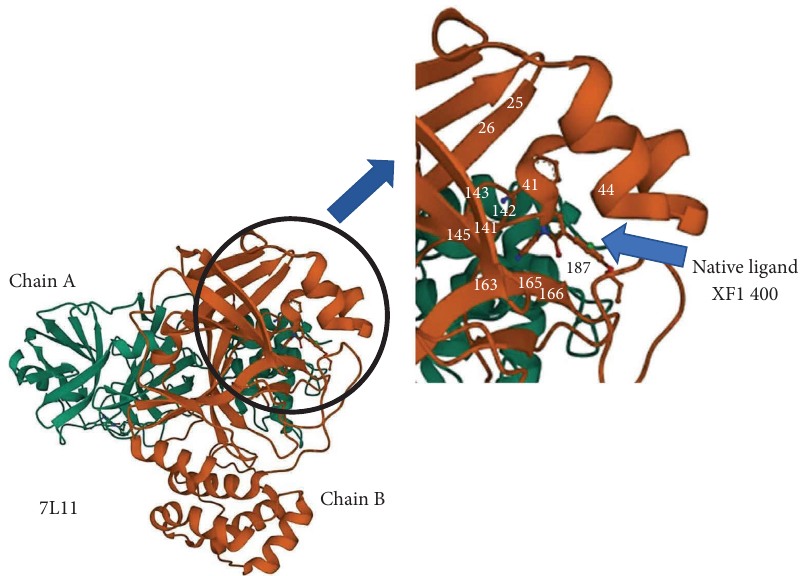
Figure 2: Residue binding site of main protease enzyme of SARS-CoV 2 (PDB ID: 7L11). Table 3: Lipinski’s rule of fve and druglikeness score.